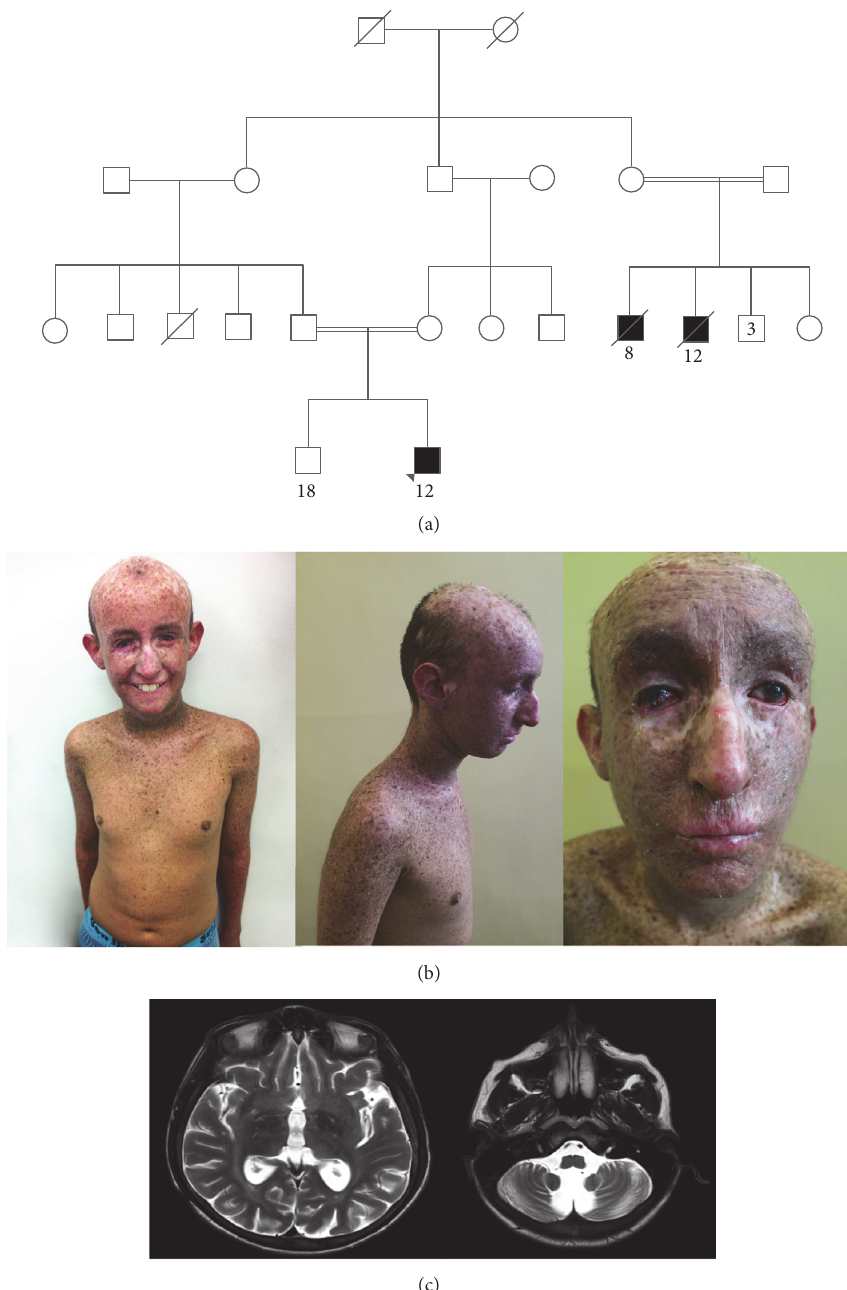
Figure 2: (a) Pedigree chart of the patient. The arrow indicates the index patient. Filled squares indicate affected individuals. (b) Photographs of the patient showing alopecia, freckle-like skin lesions, and actinic keratosis in sun-exposed areas. (c) Cerebral MRI showing parenchymal volume loss, cerebellar atrophy, and white matter